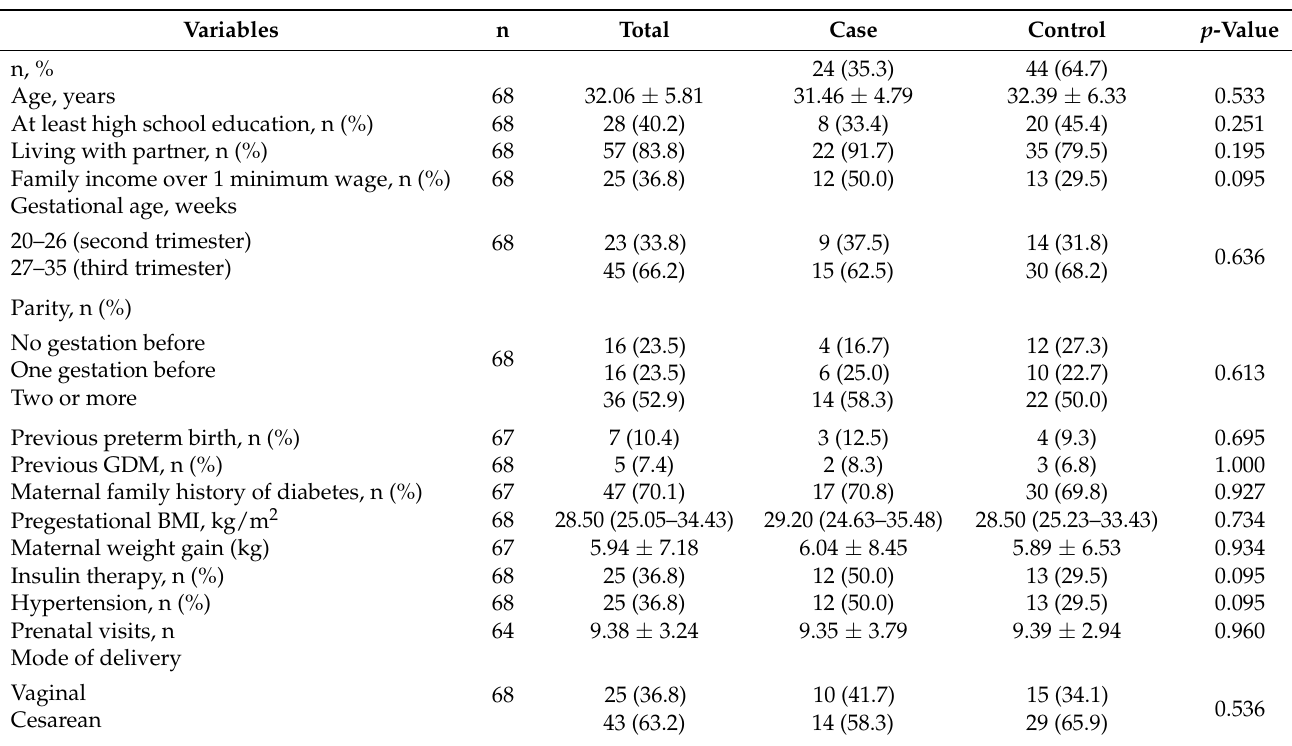
Table 1. Characteristics of case and control